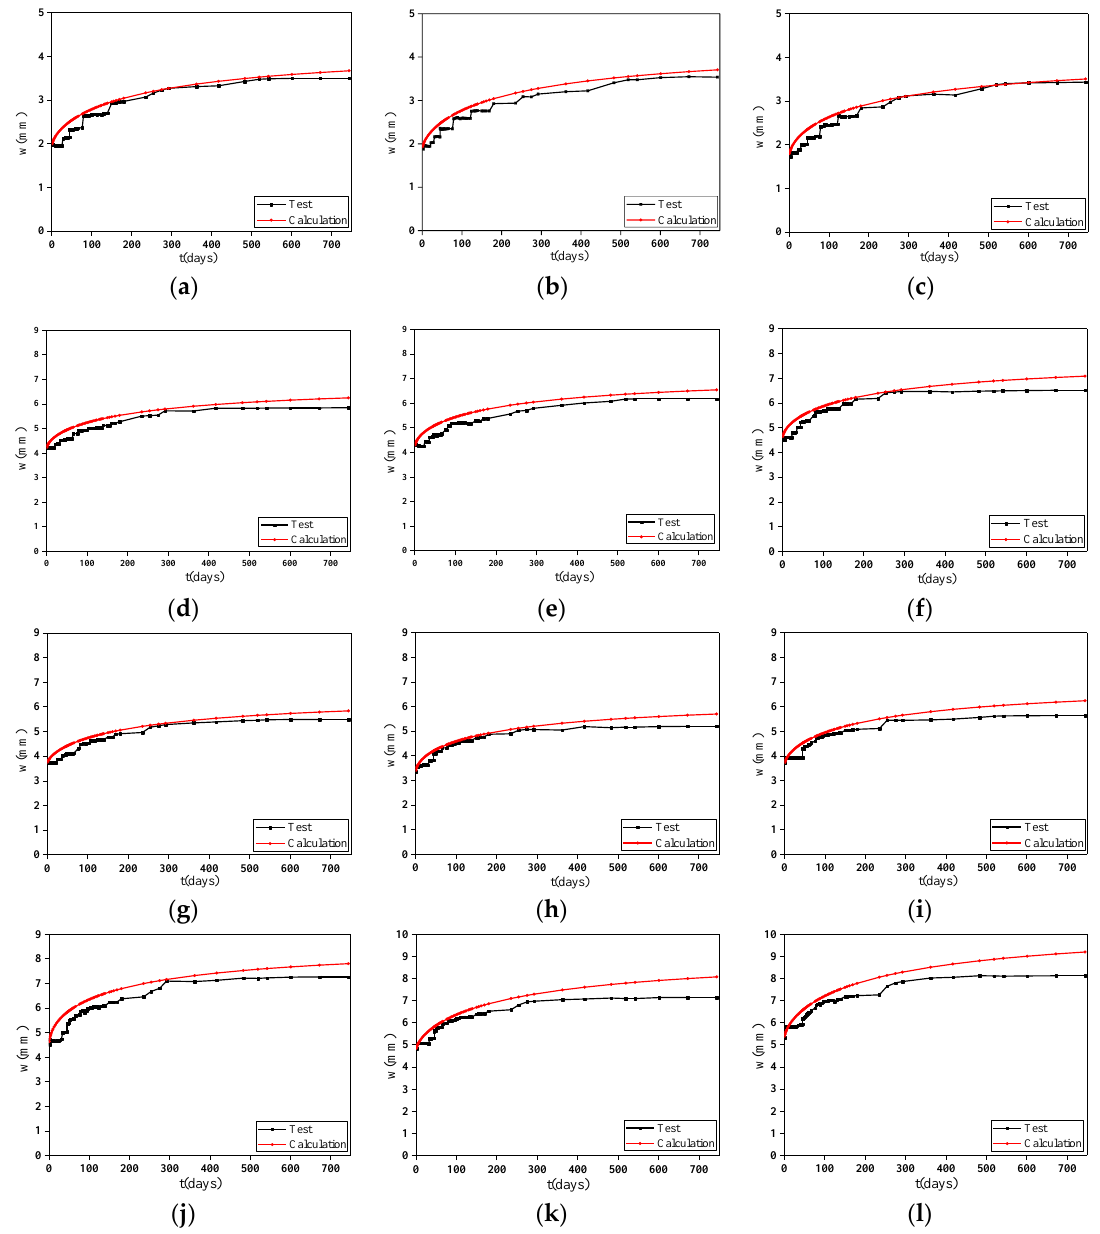
Figure 17. Comparison between the calculated values and the measured values of the RAC beams. ( a )